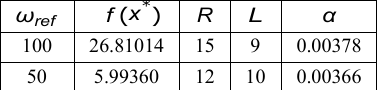
Fig. 7 present values of speed, armature current